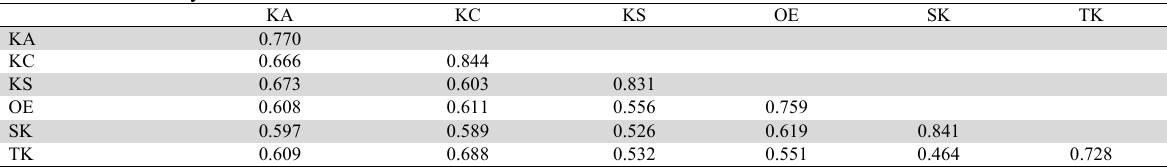
Discriminant Validity of Latent Constructs